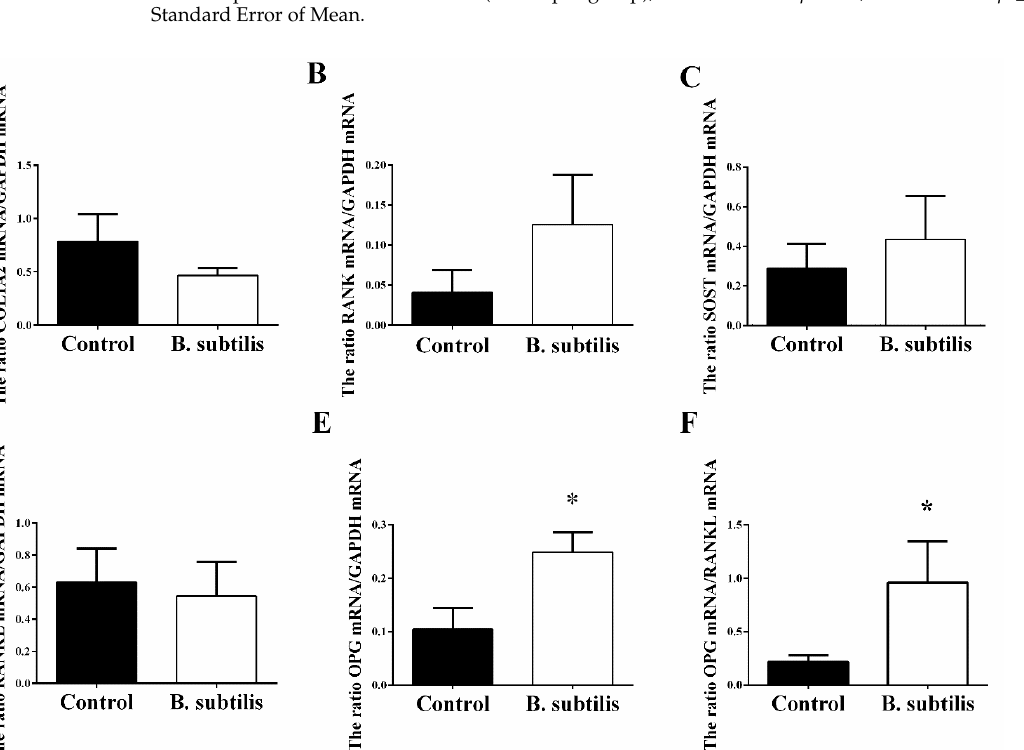
0.65 Data are presented as mean ± SEM ( n = 12 per group), + means 0.05 < p < 0.1; * means p ≤ 0.05; and ** means p ≤ 0.01.